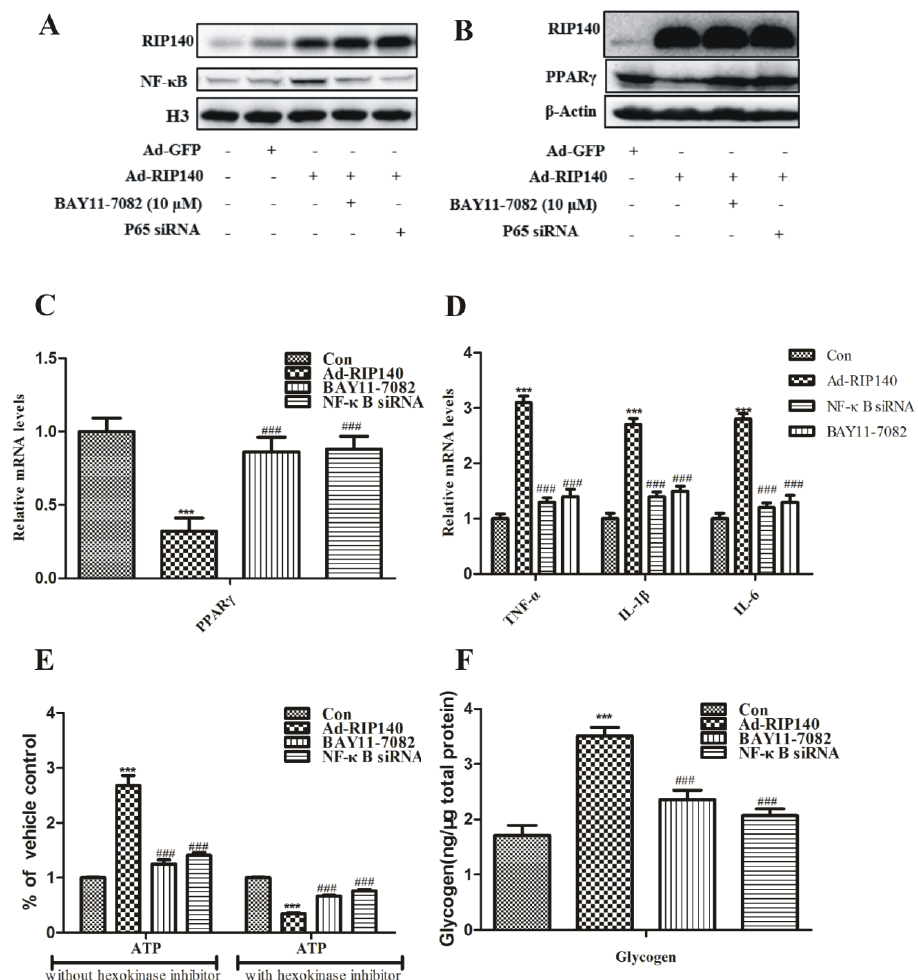
Figure 4. p65-NF- κ B inhibition partially reversed metabolic imbalance by superabundant RIP140. Figure 4. p65 ‐ NF ‐κ B inhibition partially reversed metabolic imbalance by superabundant ( A ) ARPE-19 cells were infected with Ad-RIP140 (MOI 60, 48 h), simultaneously with p65 siRNA or RIP140. ( A ) ARPE ‐ 19 cells were infected with Ad ‐ RIP140 (MOI 60, 48 h), simultaneously with p65 Bay 11-7082 (10 µ M, 24 h) treatment. ( A ) Nuclear protein levels of NF- κ B were assayed by Western siRNA or Bay 11 ‐ 7082 (10 μ M, 24 h) treatment. ( A ) Nuclear protein levels of NF ‐κ B were assayed by Western blot. ( B ) Protein levels and ( C ) mRNA levels of PPAR ‐γ , ( D ) secretion levels of TNF ‐α , IL ‐ blot. ( B ) Protein levels and ( C ) mRNA levels of PPAR- γ , ( D ) secretion levels of TNF- α , IL- β , and β , and IL ‐ 6, ( E ) ATP production, ( F ) glycogen accumulation were performed as described in the IL-6, ( E ) ATP production, ( F ) glycogen accumulation were performed as described in Section 2. Materials and Methods section. *** p < 0.001 vs. Ad ‐ GFP group. ### p < 0.001 vs. Ad ‐ RIP140 group. *** p < 0.001 vs. Ad-GFP group. ### p < 0.001 vs. Ad-RIP140